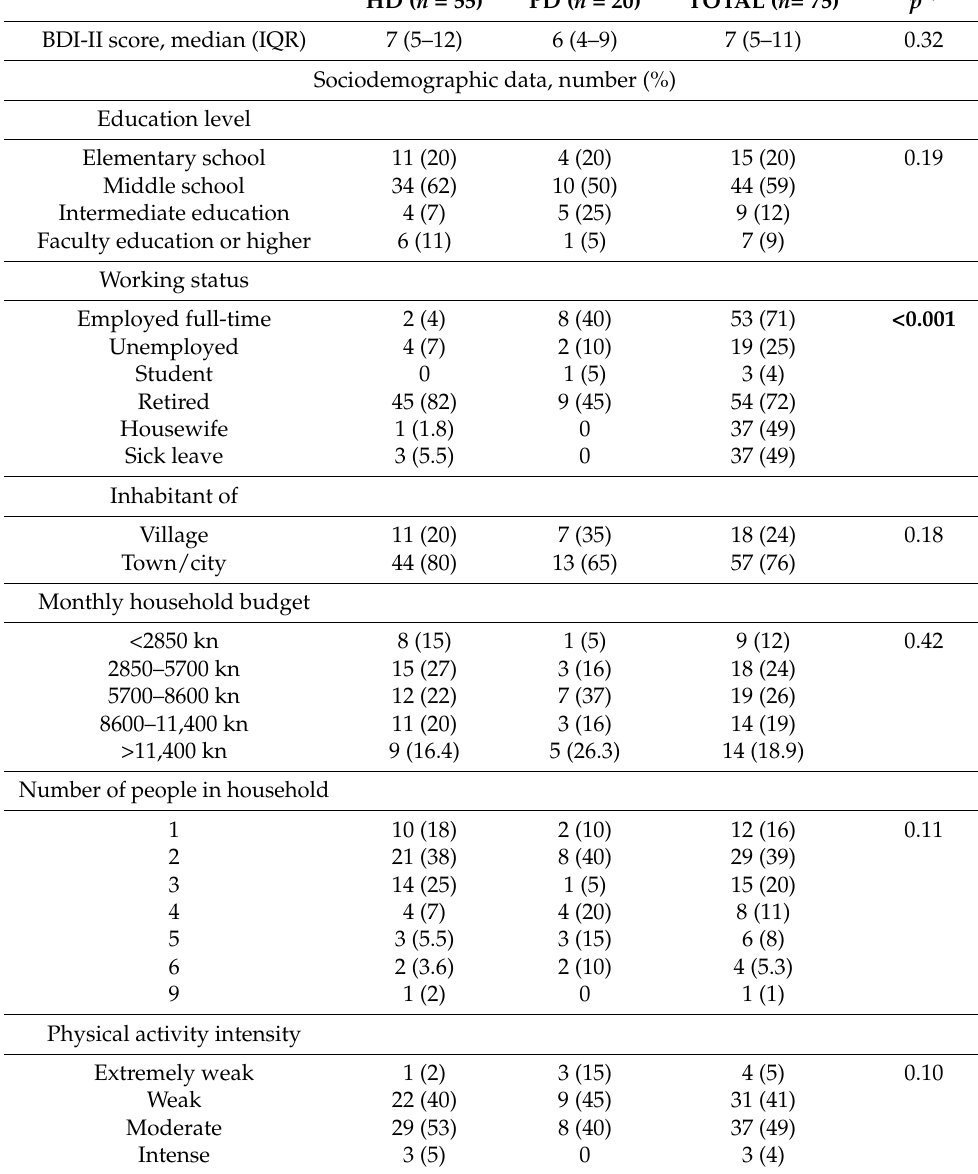
Table 2. Sociodemographic data of study